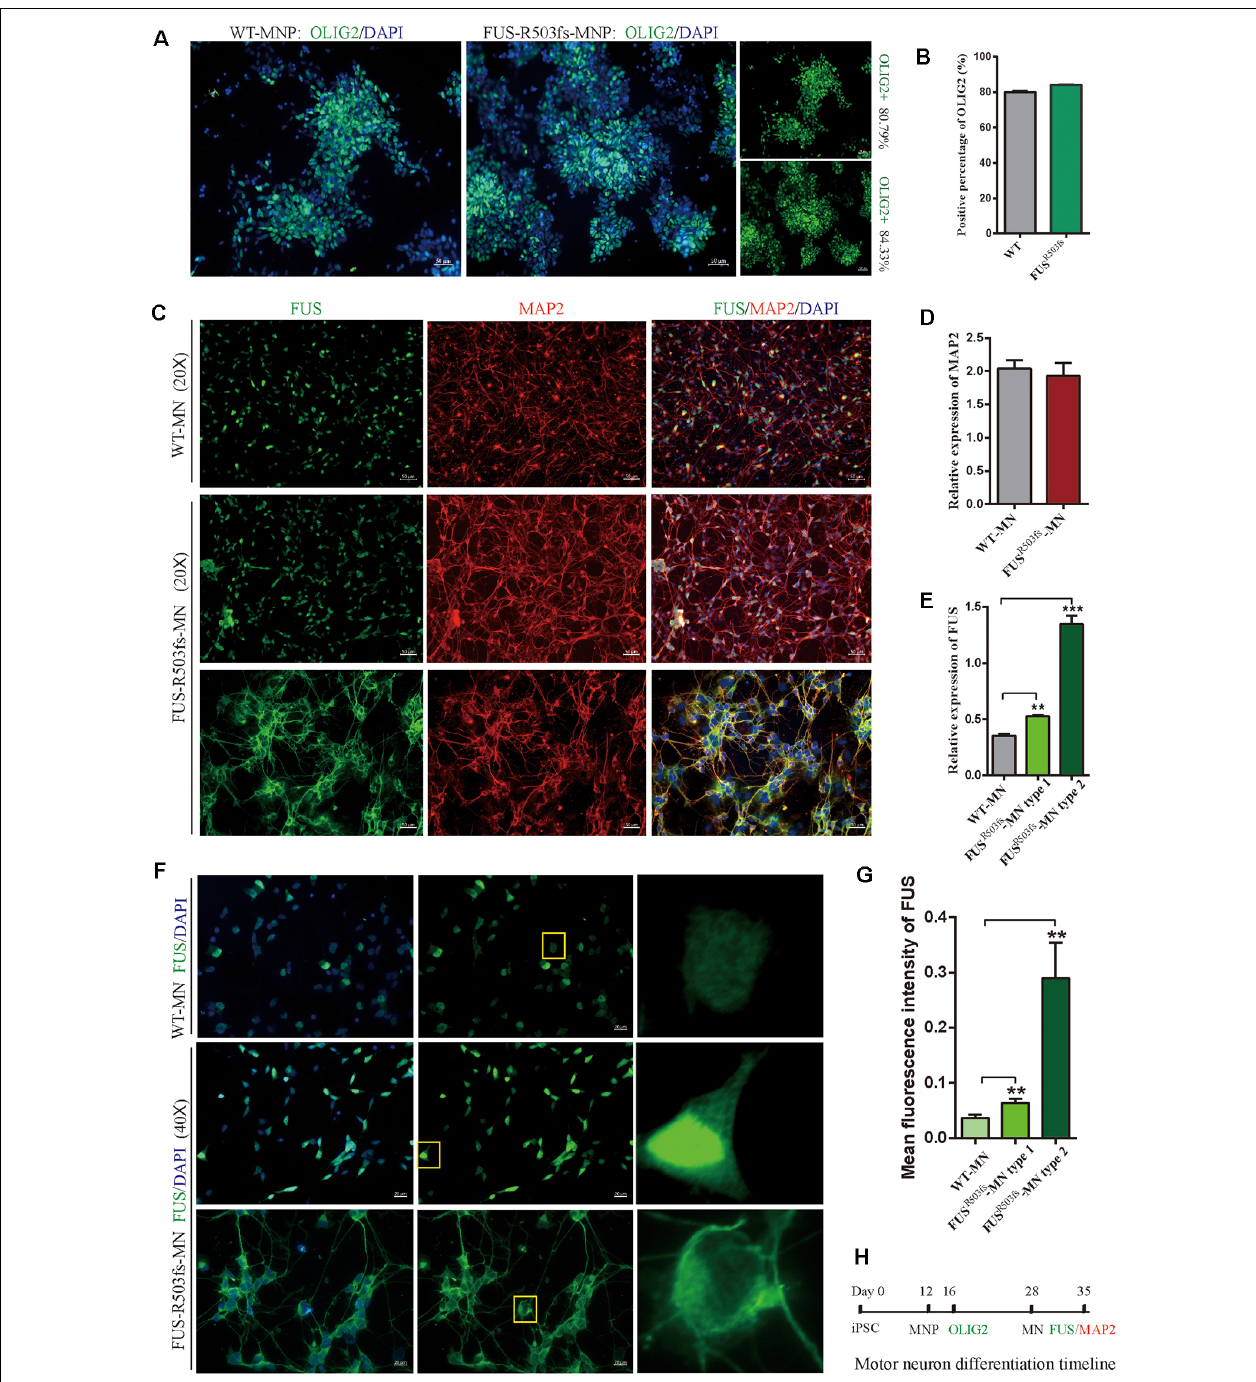
FIGURE 2 | Cells from the hiPSC line (ZZUNEUi010-A) could be differentiated into motor neurons and exhibited pathological characteristics of amyotrophic lateral sclerosis (ALS). (A) Representative images of motor neuron precursors (MNPs) on day 16 showing strong OLIG2 (green) staining. (B) There was no significant difference between FUSR503fs-MNPs and WT-MNPs in positive staining rate for OLIG2 ( n = 3, p > 0.05). (C) Representative images of motor neurons on day 35 showing positive MAP2 (red) and FUS (green) staining. (D) There was no significant difference between FUSR503fs-MNP and WT-MNP in positive staining rate for MAP2 ( n = 3, p > 0.05). (E) The relative expression of FUS was significantly higher in MNs of the FUSR503fs group than in those of the WT group ( n = 3, ** p < 0.01, *** p < 0.001). (F) Representative images of FUS-positive staining MNs in WT, FUS R503fs –MN type 1, and FUS R503fs –MN type 2 groups. (G) The mean intracellular FUS fluorescence intensity of single cell was significantly higher in MNs of the FUS R503fs group than in those of the WT group (WT-MNs, n = 142; FUS R503fs –MN type 1, n = 146; FUS R503fs –MN type 2, n = 75; ** p < 0.01). (H) Schematic diagram of motor neuron differentiation process.